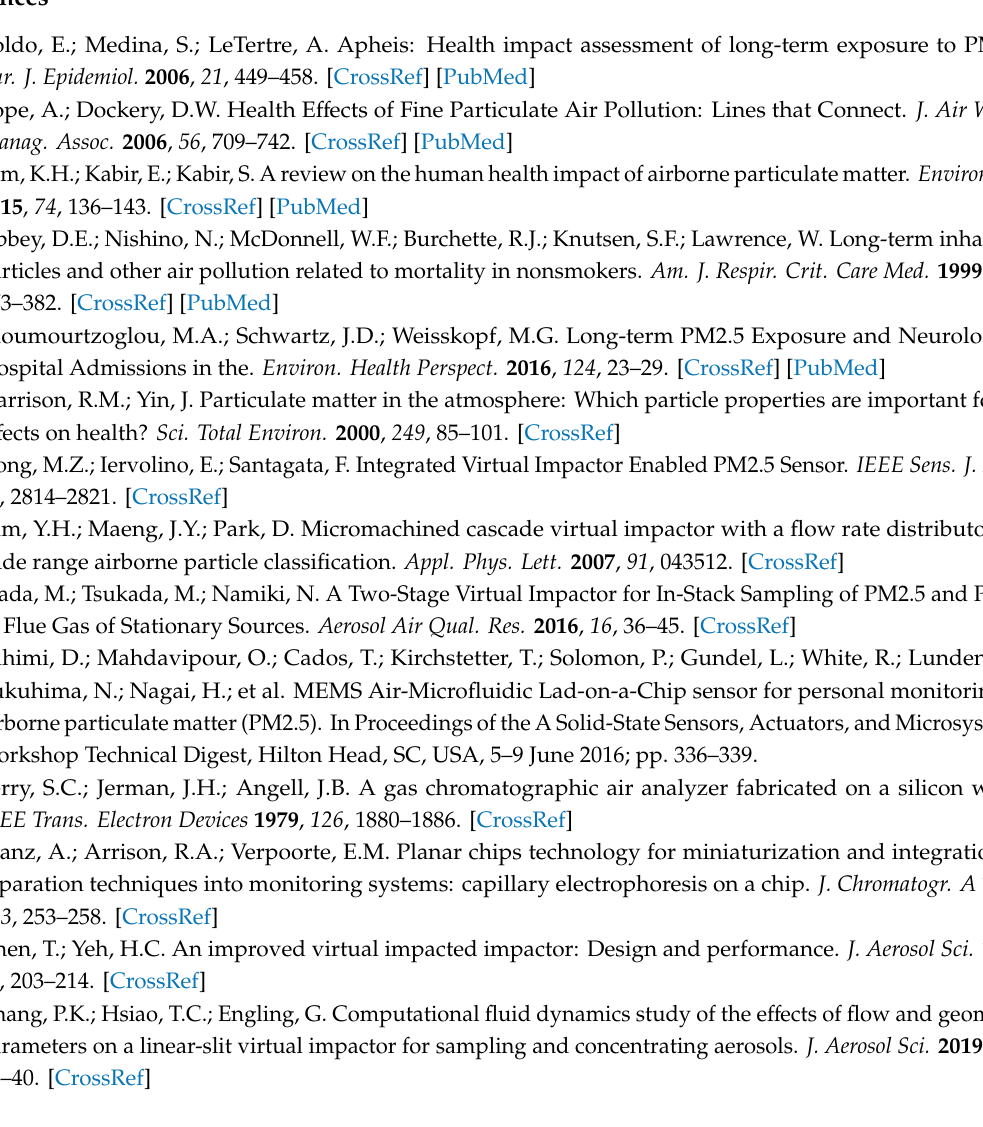
As the number of stages increases, the steepness